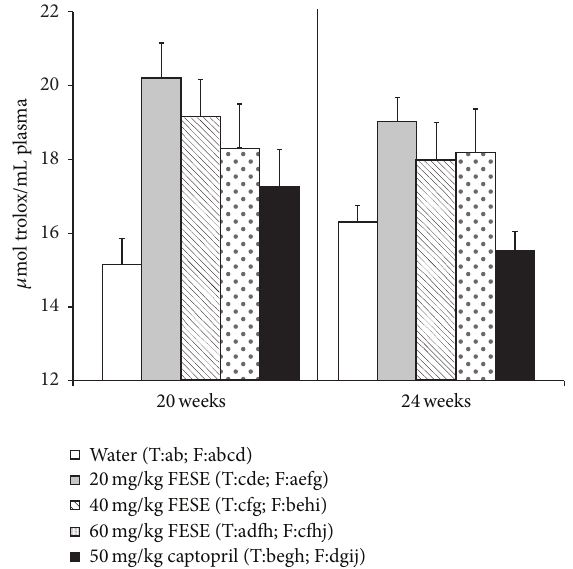
Figure 4: Histograms of the oxygen radical absorbance capacity (ORAC) of plasma samples ( 𝜇 mol Trolox/mL plasma) from spon- taneously hypertensive rats. The animals drank different fluids from weaning until the 20th week of life (treatment period = T) and received therefore different daily treatments: tap water, 20 mg/kg/day Fraxinus excelsior L. seed extract (FESE), 40 mg/kg/ day FESE, 60 mg/kg/day FESE, or 50 mg/kg/day captopril. All rats drank tap water from the 20th week of life until the 24th week of life (follow-up period = F). Data are mean values ± SEM for 10 animals in T and for 5 animals in F. Similar letters represent no statistical differences ( 𝑃 > 0.05 ). 𝑃 estimated by one-way